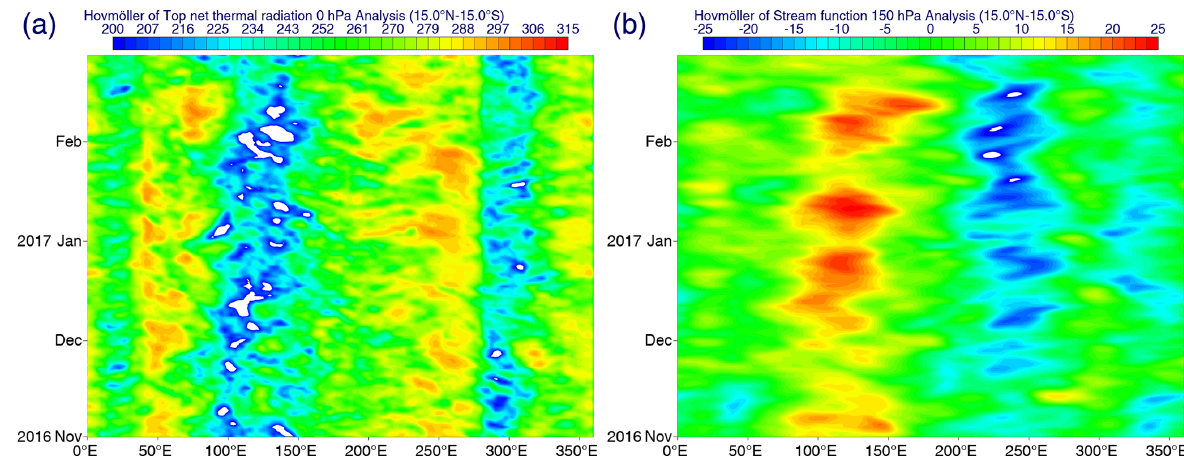
Figure 1. Time–longitude sections of the ECMWF analysis averaged over 15 ◦ S–15 ◦ N for (a) OLR (K, as equivalent black-body tempera- ture) and (b) the stream function (s − 1 ) at 150hPa for the 4-month winter period of 2016–2017. In averaging the stream function, the sign is flipped for the Southern